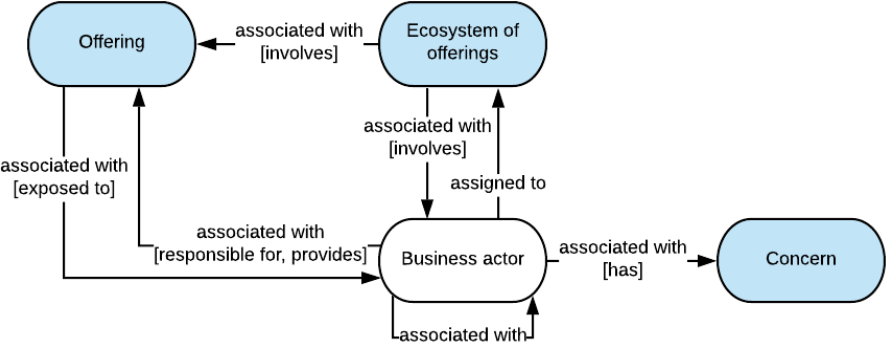
Figure 5. Ecosystem of offerings – included